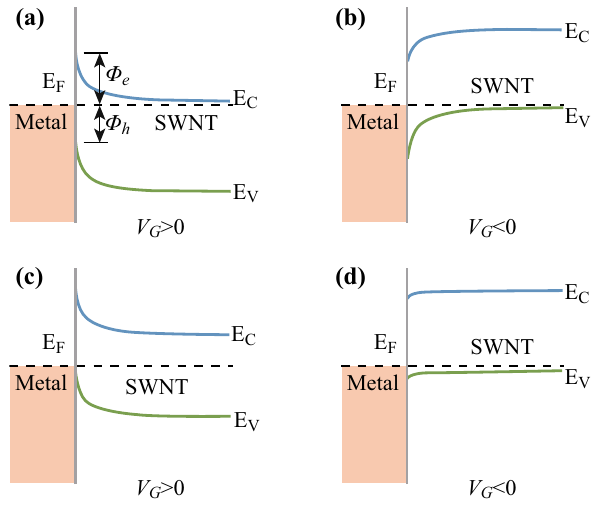
Fig. 4 Schematics of the bands along the length of the SWNT at different temperatures and gate voltages. a , b At low temperature ( T \ 50 K), bands of the ambipolar SWNT device at V G (cid:5) 0 (strong electron injection) and V G (cid:6) 0 (strong hole injection). c , d At high temperature ( T [ 100 K), bands of the p -type SWNT device at V G (cid:5) 0 and V G (cid:6) 0. U b shows the barrier height of the